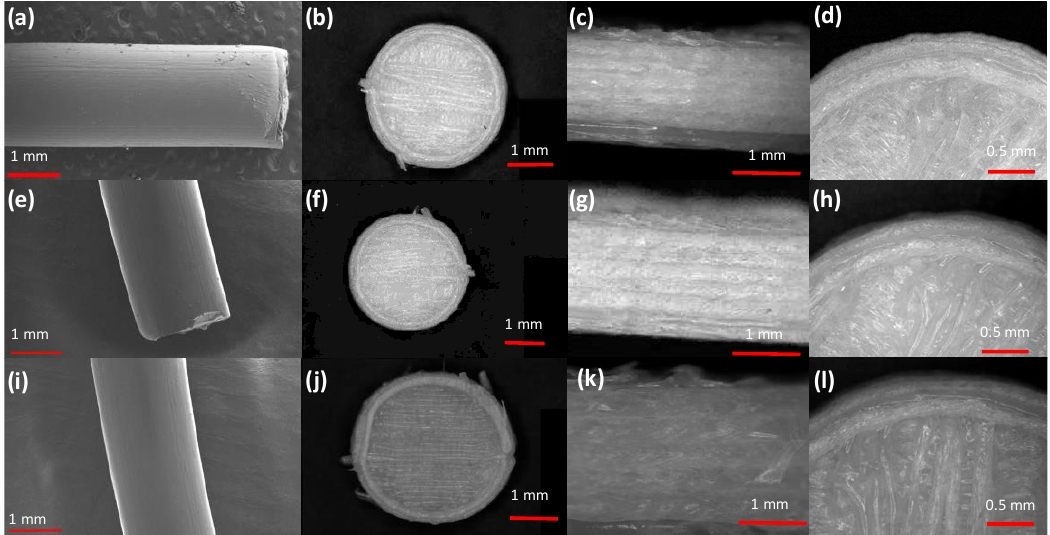
Figure 5. SEM micrographs of ( a – d ) K4M based filament and matrix tablet (a = filament, b = whole matrix tablet, c = side view of matrix tablet and d = surface view showing edges), ( e - h ) K15M based filament and matrix tablet (e = filament, f = whole matrix tablet, g = side view of matrix tablet and h = surface view showing edges) and ( i – l ) K100M based filament and matrix tablet (i = filament, j = whole matrix tablet, k = side view of matrix tablet and l = surface view showing edges).